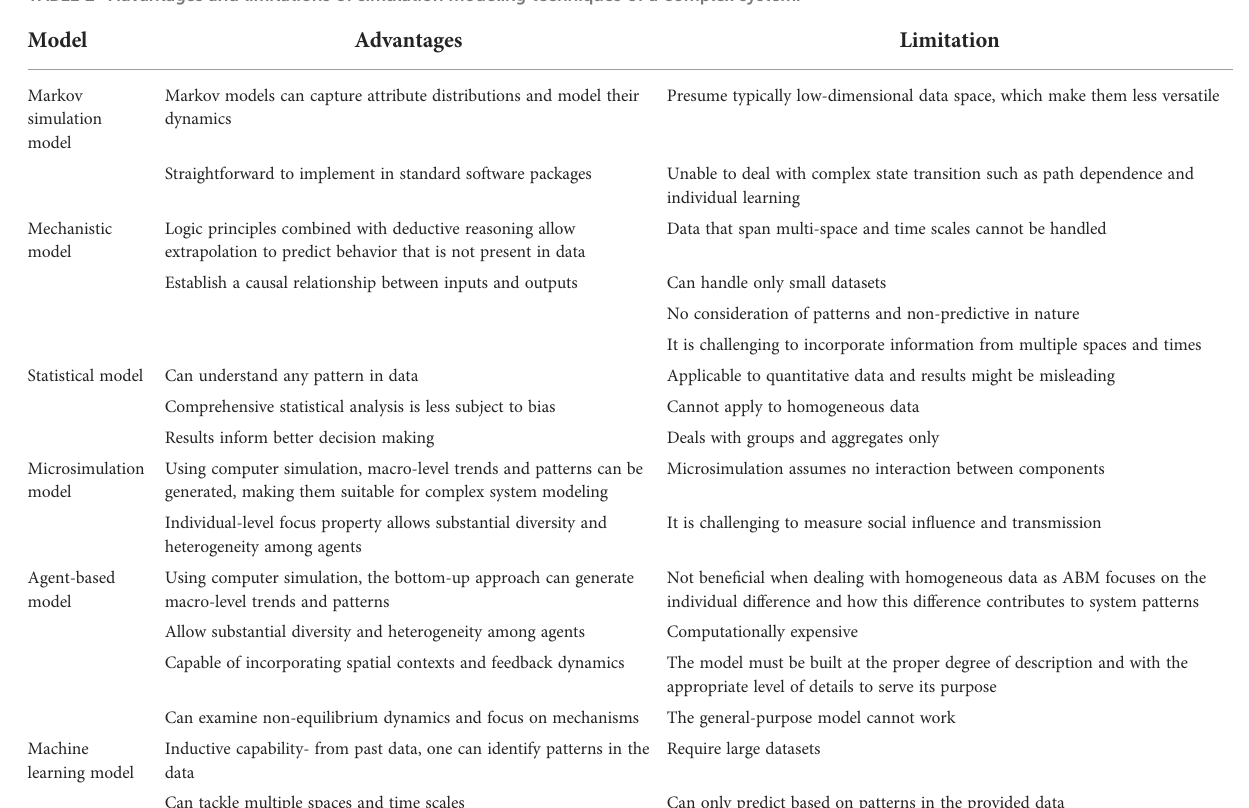
TABLE 2 Advantages and limitations of simulation modeling techniques of a complex